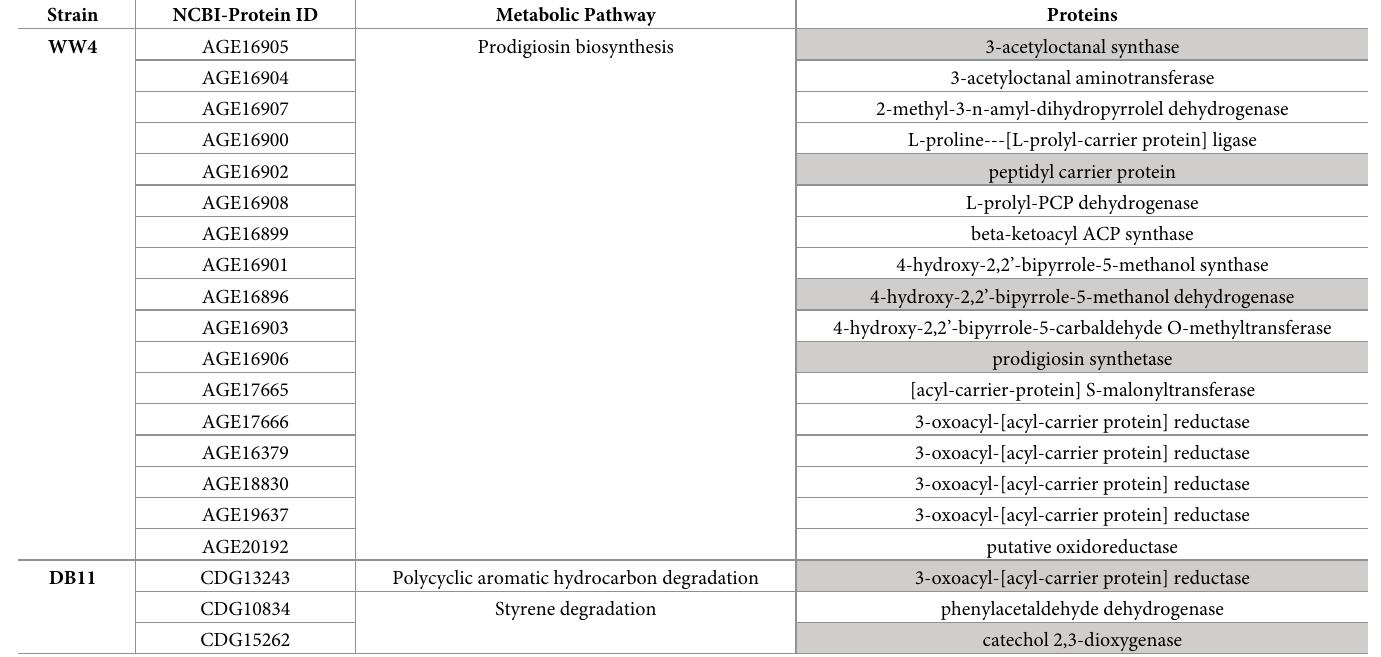
Table 3. List of 20 shortlisted proteins and their unique metabolic